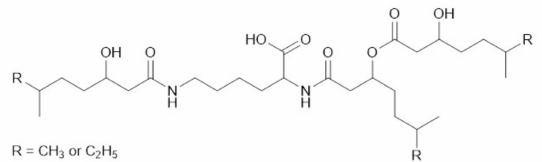
Figure 3. The structures of isolated dudomycins. In the case of dudomycin A, all three R groups correspond to the CH 3 group. Dudomycin B is a mixture of 3 constitutional isomers with two R groups corresponding to CH 3 and one R group—to C 2 H 5 . Dudomycin C is a mixture of 3 constitutional isomers with one R group corresponding to CH 3 and two R groups—to C 2 H 5 . In dudomycin D, all three R groups correspond to C 2 H 5